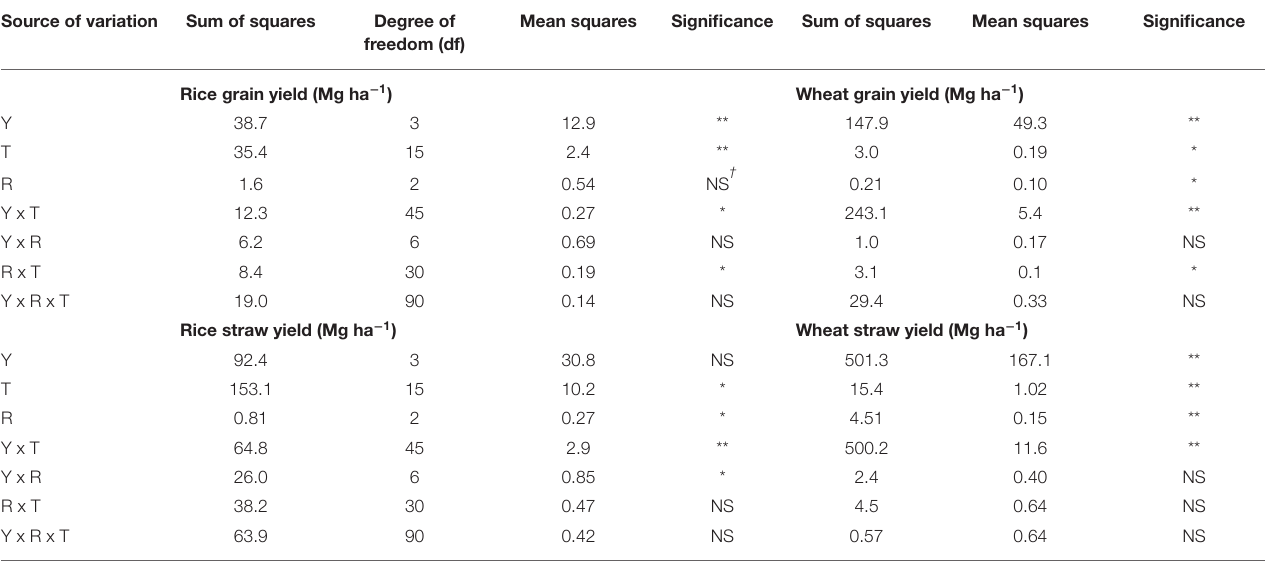
TABLE 2 | Results of two-way analysis of variance (ANOVA) on the effects of years (Y), treatments (T), replications (R), and their interaction effect on rice and wheat yields (grain and straw). Source of